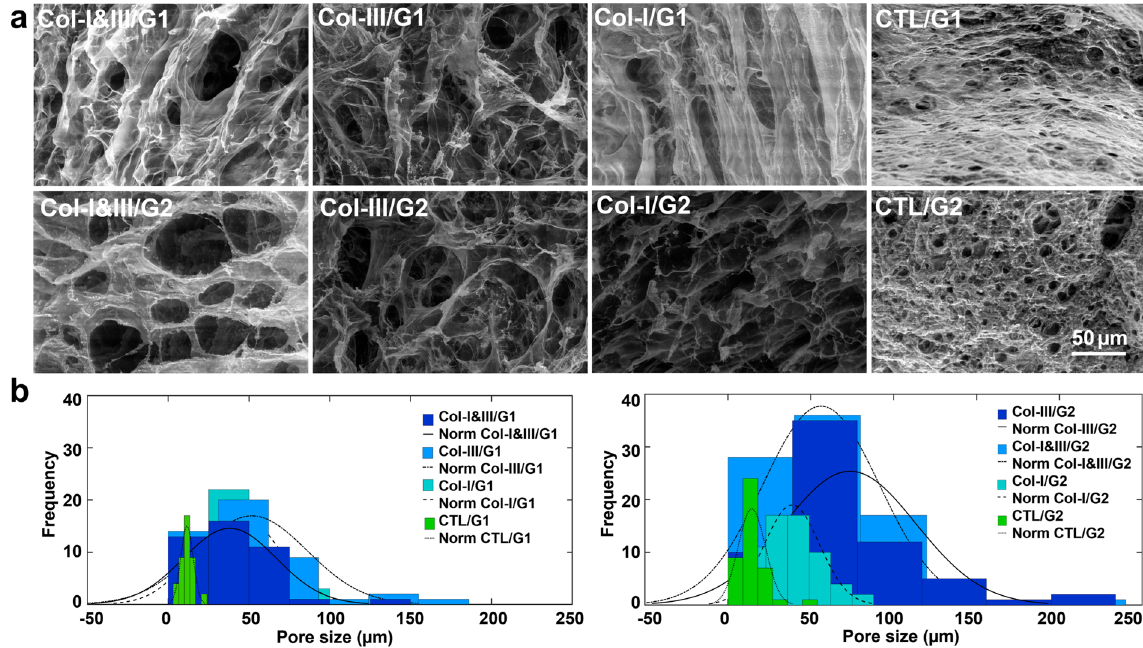
Figure 3. Environmental scanning electron microscopy (ESEM) results. ( a ) Representative ESEM images of Col-I&III/glycol-chitosan (GCS), Col-III/GCS, positive control (Col-I/GCS) and negative control (CTL/ GCS) hydrogels. Porous structures with interconnected pores of irregular shapes were found for the Col/GCS hydrogels. Rounded closed pores with smaller dimensions were found for the negative controls. The pore size increased with the incorporation of collagen in GCS hydrogels; ( b ) Histograms of the measured pore sizes out of three replicates for each study group. The mode was slightly larger for Col-III/GCS hydrogels, compared with those of associated Col-I&III/GCS hydrogels and positive controls (Col-I/GCS), which were all greater than those of the associated negative controls (Col-III: collagen type III, Col-I: collagen type I, Col-I&III: the simultaneous presence of Col-I and Col-III, and CTL: negative controls. G1 and G2 represent the final GCS concentration of 2% and 1%,